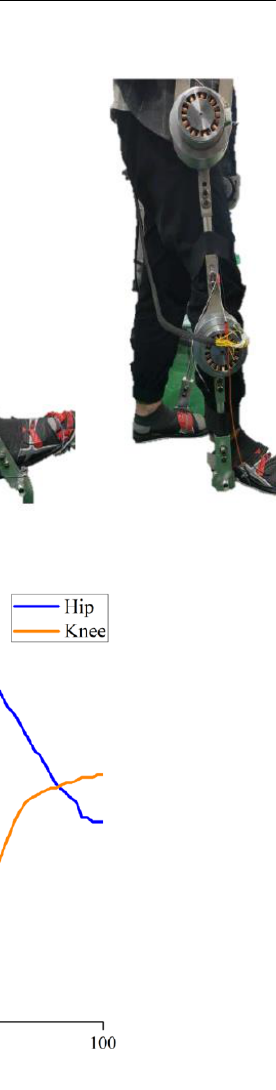
Figure 18. Gait data of normal walking motion.